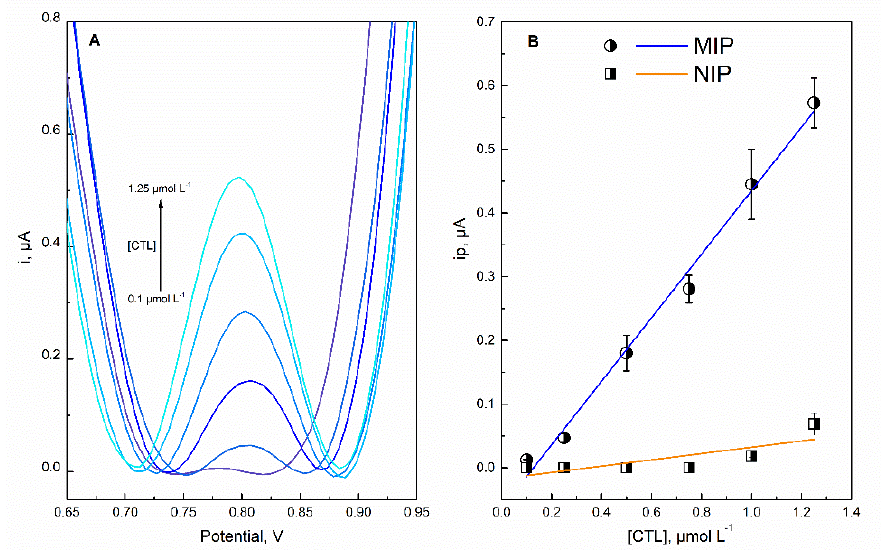
Figure 7. ( A ) SWV obtained from MIP response to CTL concentration in the range of 0.1–1.25 μ mol L − 1 ; ( B ) calibration plots for MIP and NIP sensors showing the relationship of CTL concentrations with the peak current intensity.